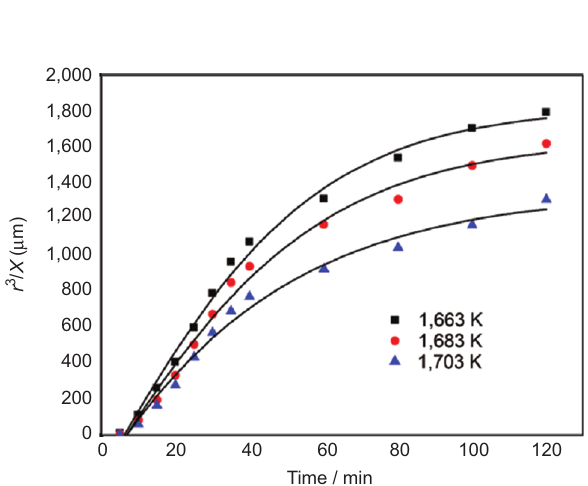
Figure 7: The variation of r 3 / X with time.